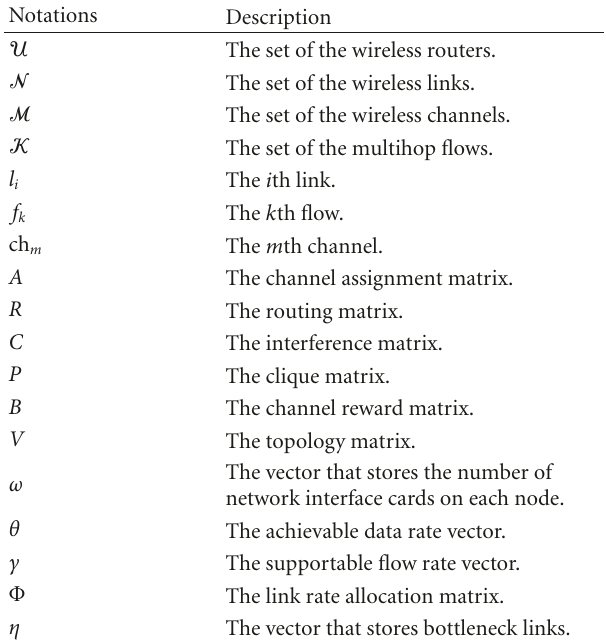
Table 1: Notations in system model and problem